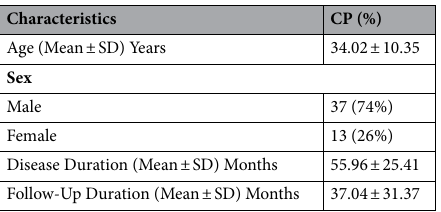
Table 7. Clinical characteristics of the CP patients (n =